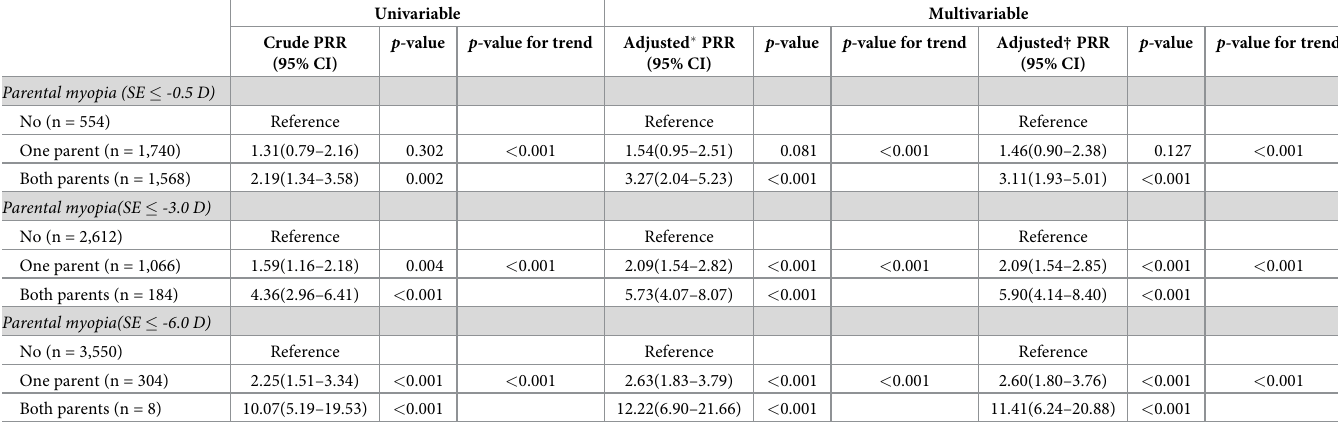
Table 3. Prevalence rate ratios and 95% confidence intervals for pediatric high myopia (SE � -6.0 D) according to the presence of parental